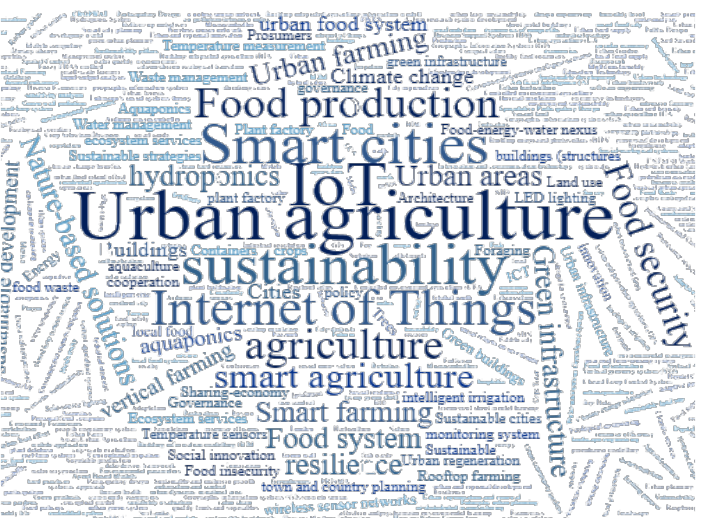
Figure 2. Word cloud for all keywords of the selected papers included in the systematic review sorted by frequency. Source: Authors